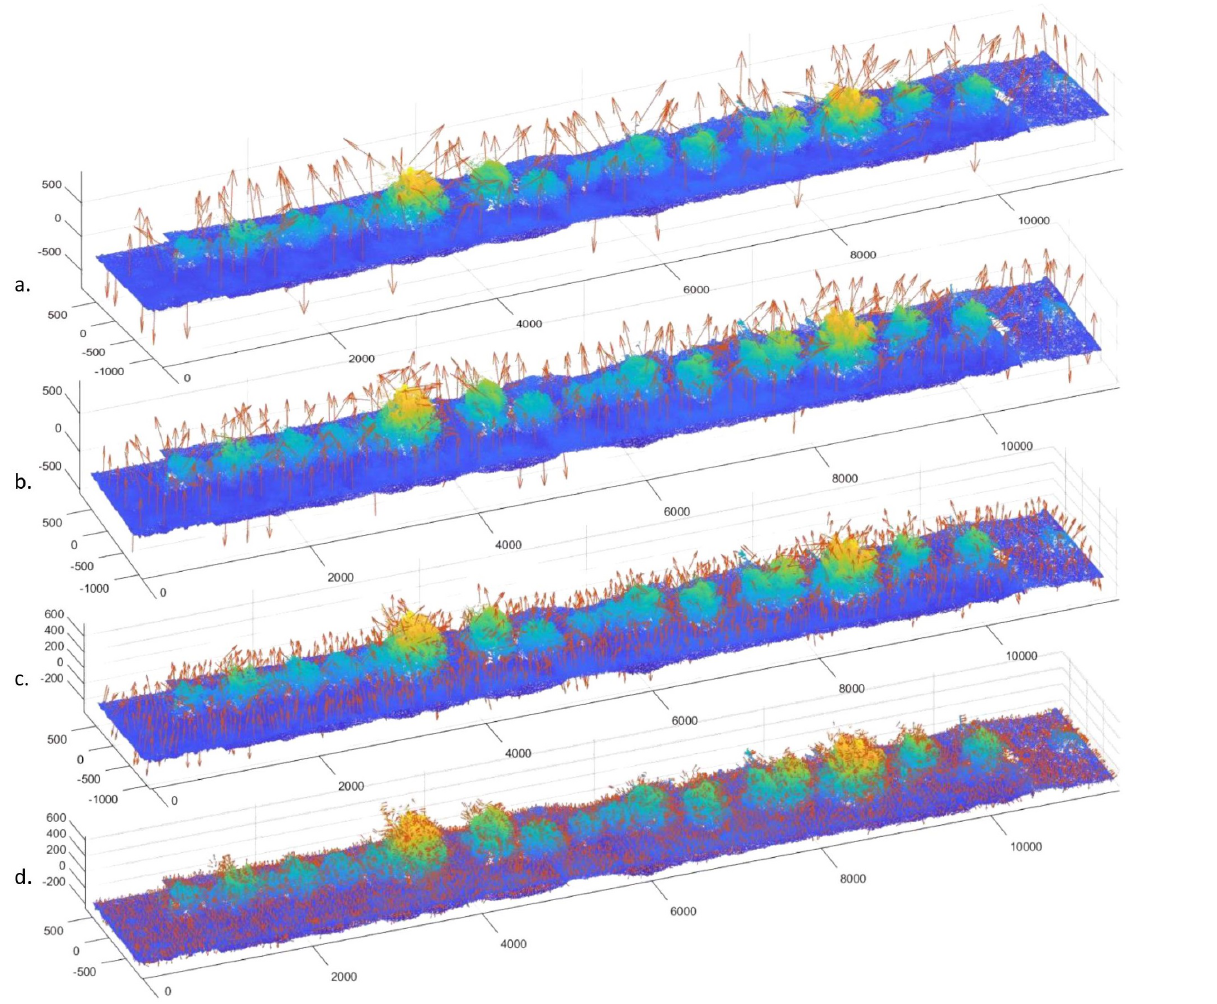
Figure 7. Normals calculated from G-PC with different down-sample levels applied, ( a ) 60%, ( b ) 40%, ( c ) 22%, ( d ) 10%, represented on the original point cloud (G-PC). Source: